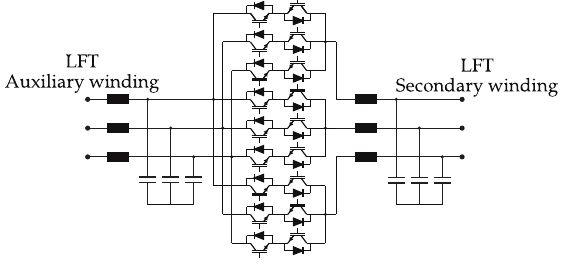
Figure 8. Direct matrix converter. Table 2. AC choppers ideal voltage